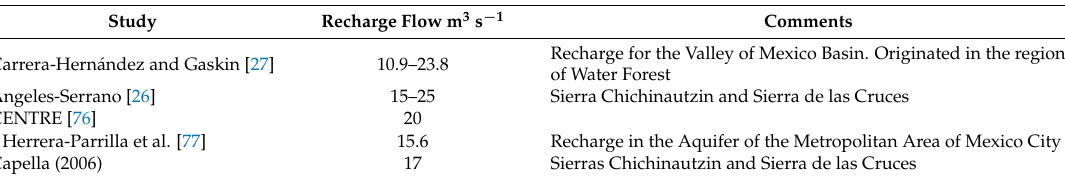
Table 2. Recharge flows estimation in the